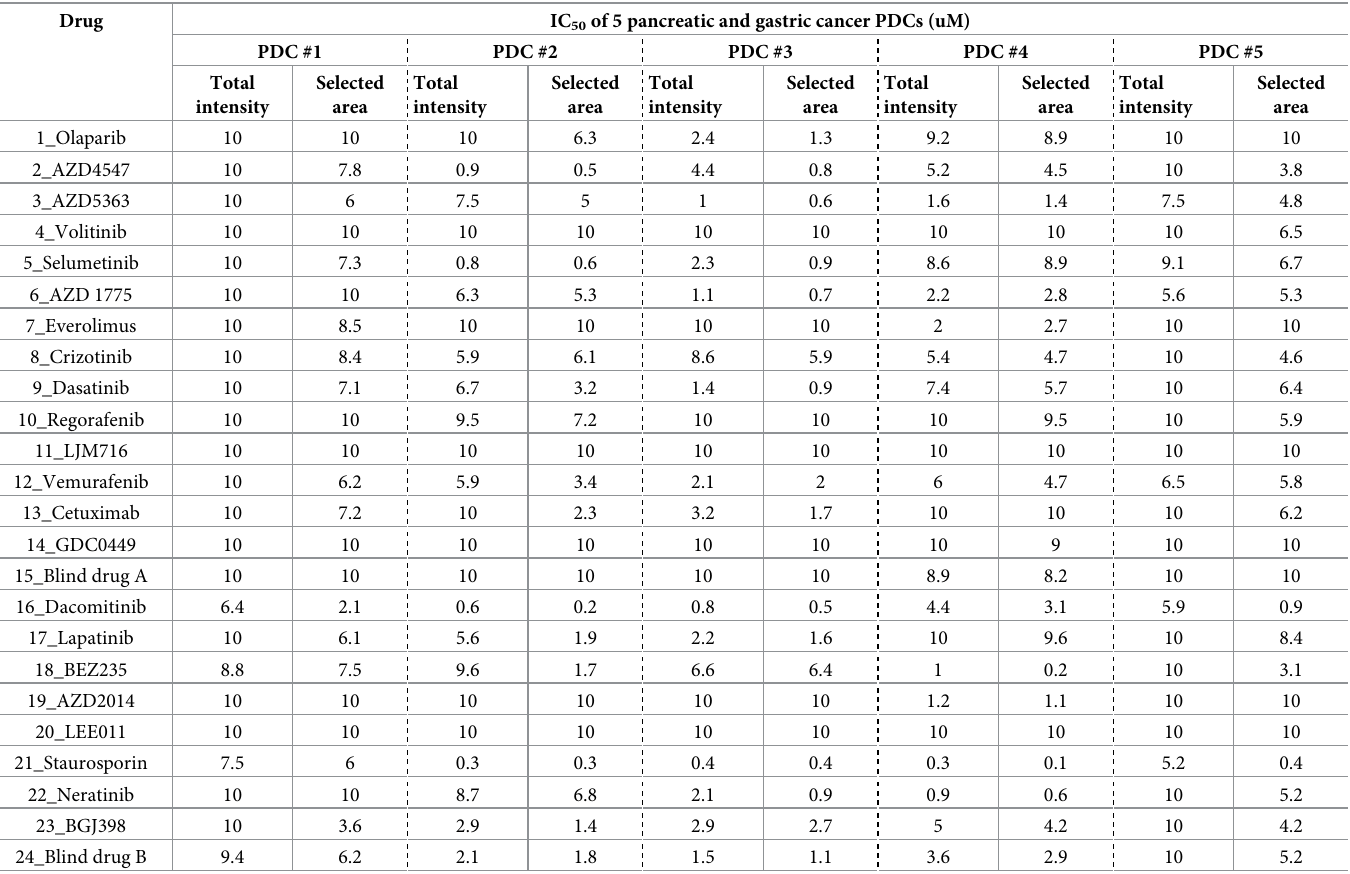
Table 2. IC 50 of Pancreatic and Gastric cancer patient derived cancer cells (PDCs). Drug IC 50 of 5 pancreatic and gastric cancer PDCs